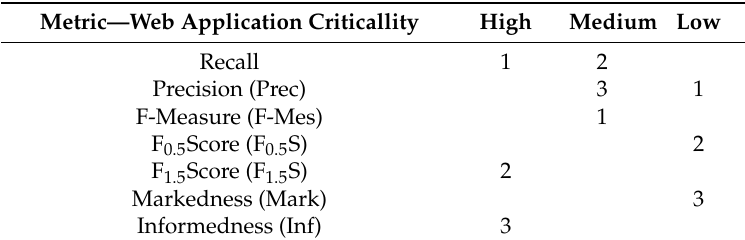
Table 8. Selection of metrics by web application criticality. Metric—Web Application Criticallity High Medium Low